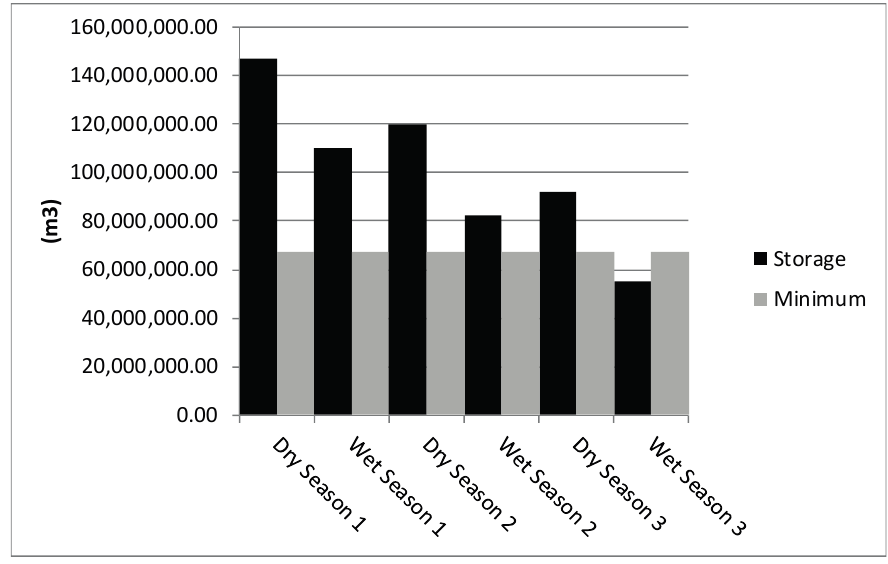
Figure 8. The SPEI and wet season under a worst-case drought